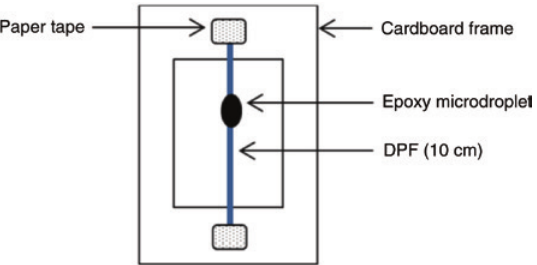
Figure 2: Schematic representation of template used in the prepa- ration of samples for microbond test.